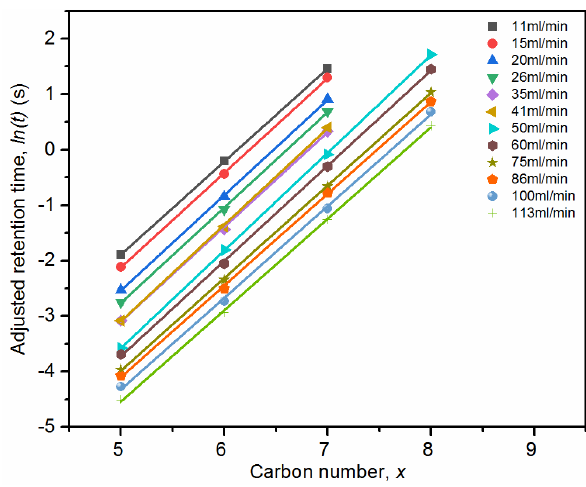
Figure 7: Adjustment retention time of probe molecules for sample N375-300 ∘ C